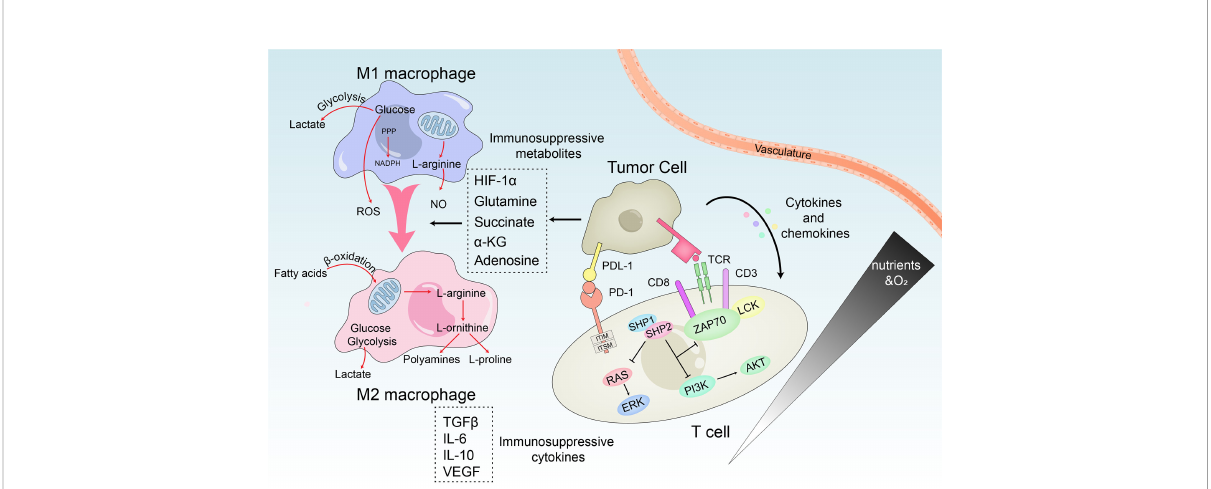
FIGURE 4 Metabolic crosstalk within the immunosuppressive microenvironment. M1 macrophages rely on the production of lactate, ROS and NO to kill tumor cells, while M2 macrophages mainly promote tumor growth through b -oxidation of fatty acids and polyamines and L-proline produced by the TCA cycle. In HCC, TME reprogram macrophage metabolism through immunosuppressive metabolites and induces the repolarization of M1 to M2. Similarly, the interaction of immune regulatory cells and cytokines disables the anti-tumor T cell response. PD-1 accompanied with PD-L1 directly inhibits T cell receptor signaling by preventing phosphorylation of ZAP70. Meanwhile, the PI3K/Akt and Ras/MEK/Erk pathways required to initiate T cell activation are also be